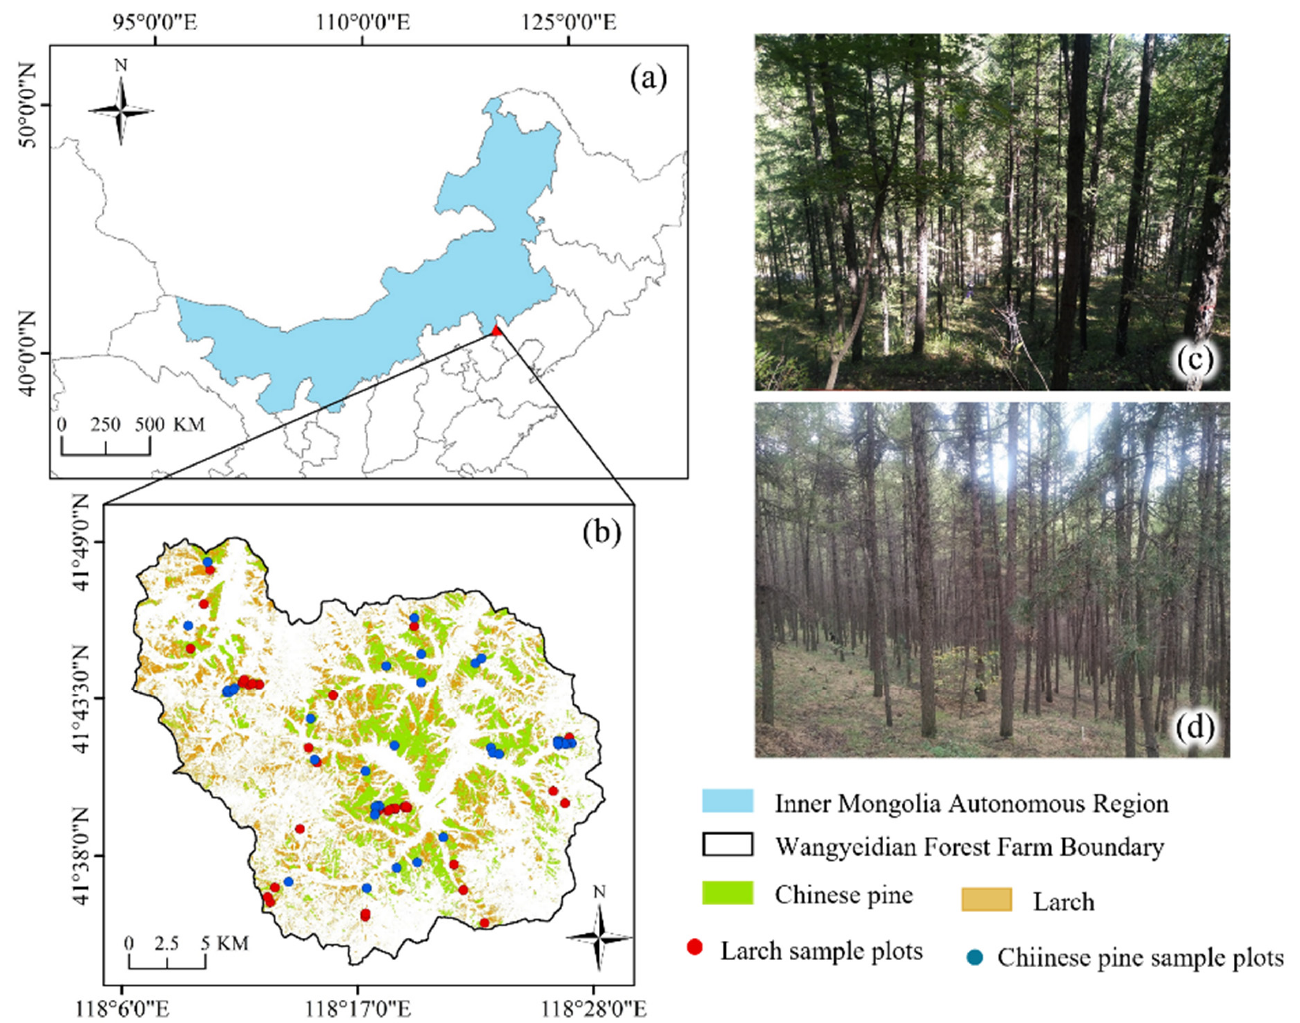
Figure 1. Location map of the study area: ( a ) is the boundary of Inner Mongolia Province, ( b ) is the boundary of the Wangyedian forest farm, ( c ) is a photo of Chinese pine in the sample plots, and ( d ) is a photo of larch in the sample plots.